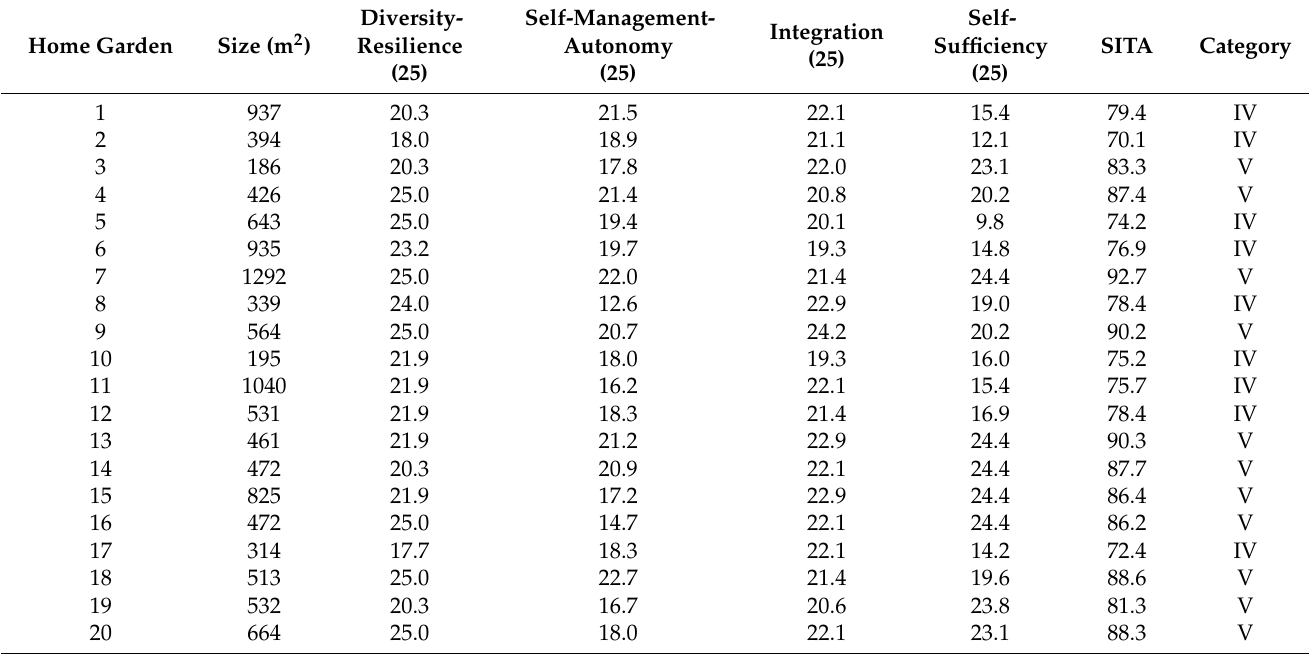
Table 4. Home garden’s values of diversity-resilience, self-management-autonomy, integration, and self-sufficiency of SITA.